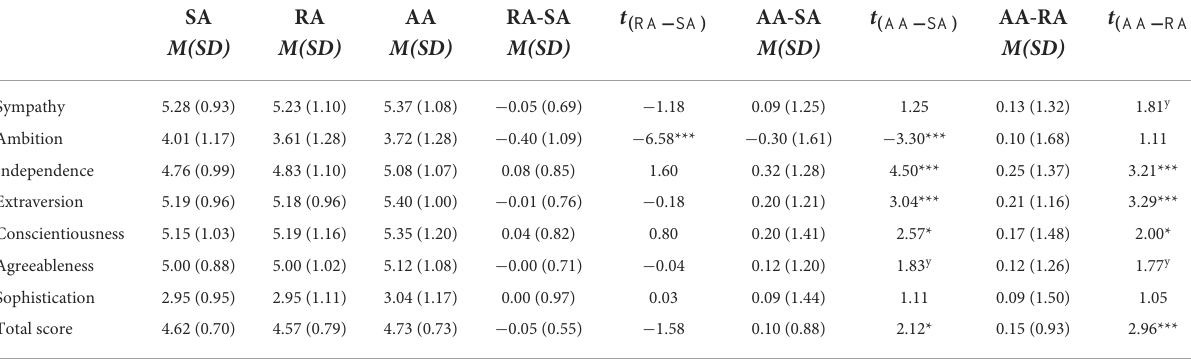
TABLE 1 Descriptive statistics among the three types of appraisals.